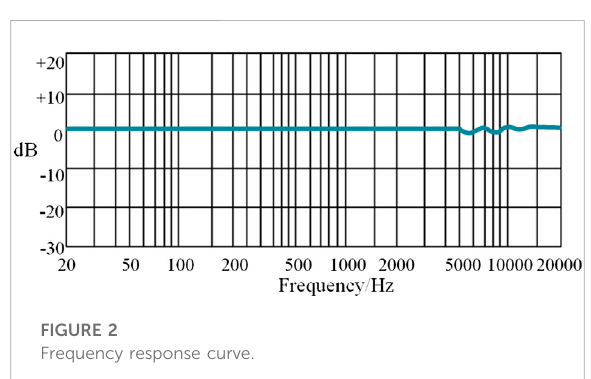
FIGURE 2 Frequency response